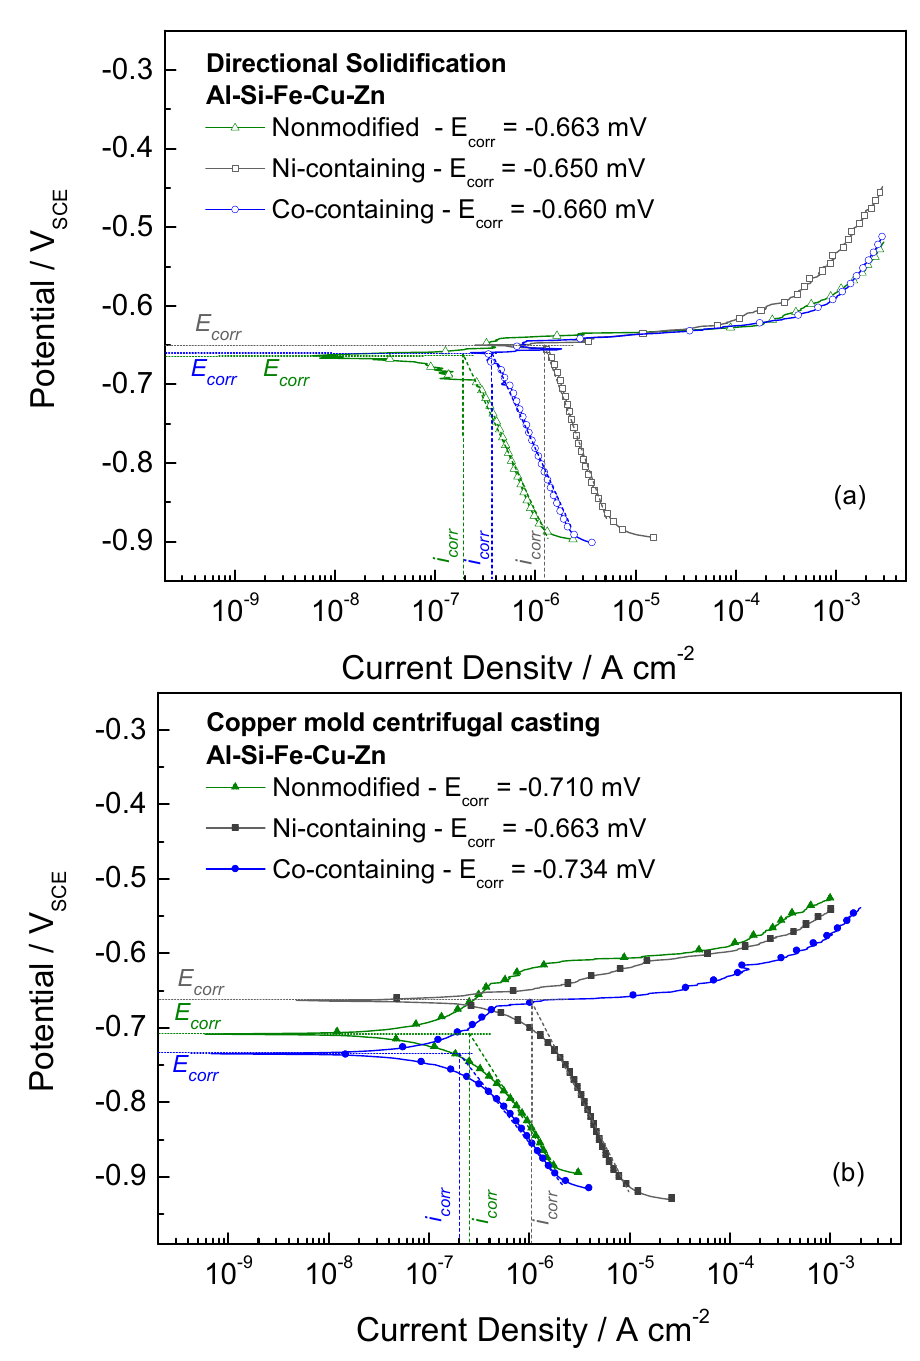
Figure 4. Potentiodynamic polarization curves for the Al-Si-Fe-Cu-Zn (-Co, -Ni) alloy samples having different SDAS: Approximately ( a ) 21 µ m, ( b ) 5 µ m. Linear cathodic branch along about one-decade of current in potential values sufficient far from E corr was used for estimation of i corr . Such estimation of i corr was intended for comparative purposes among the alloys in this study rather than as a definitive and accurate indication of the corrosion kinetics.